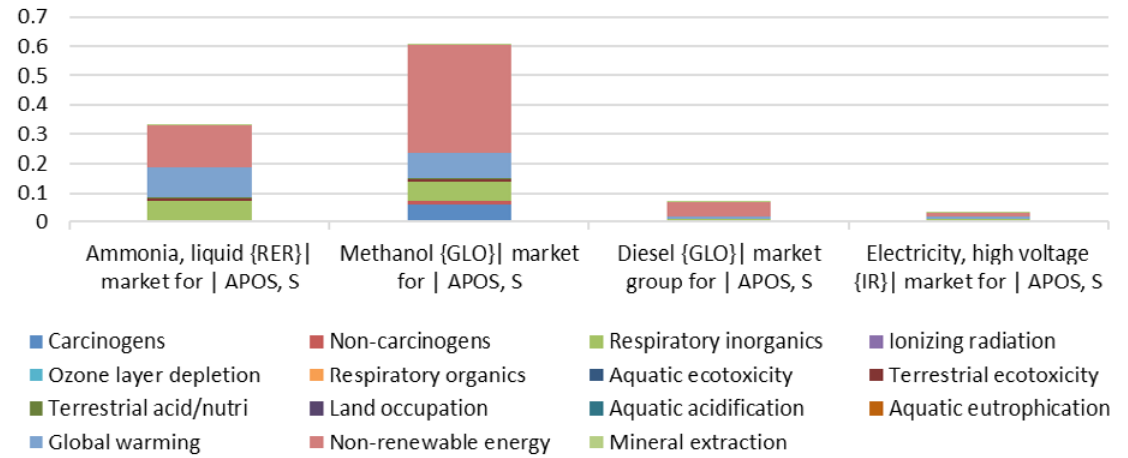
Figure 15. Final environmental points (single score) of life cycle scores by the impact 2002+ method